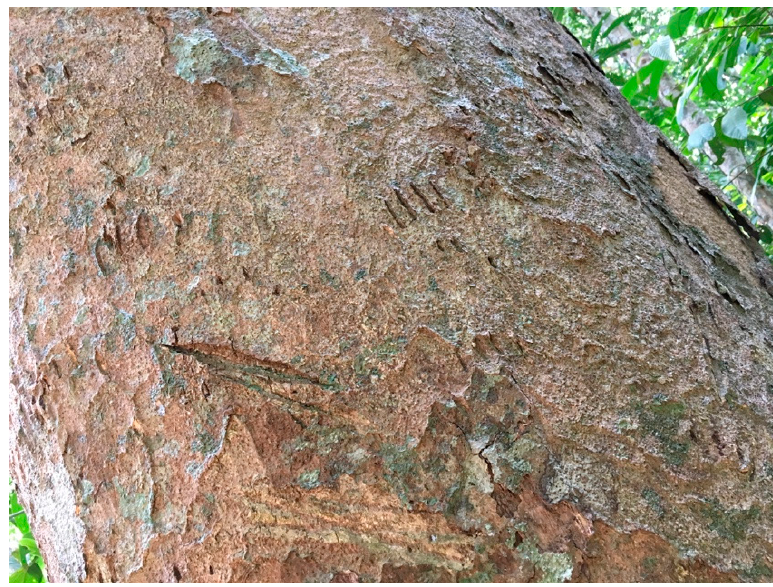
Figure 4. Recent sun bear markings on a tree inside the adat forest.